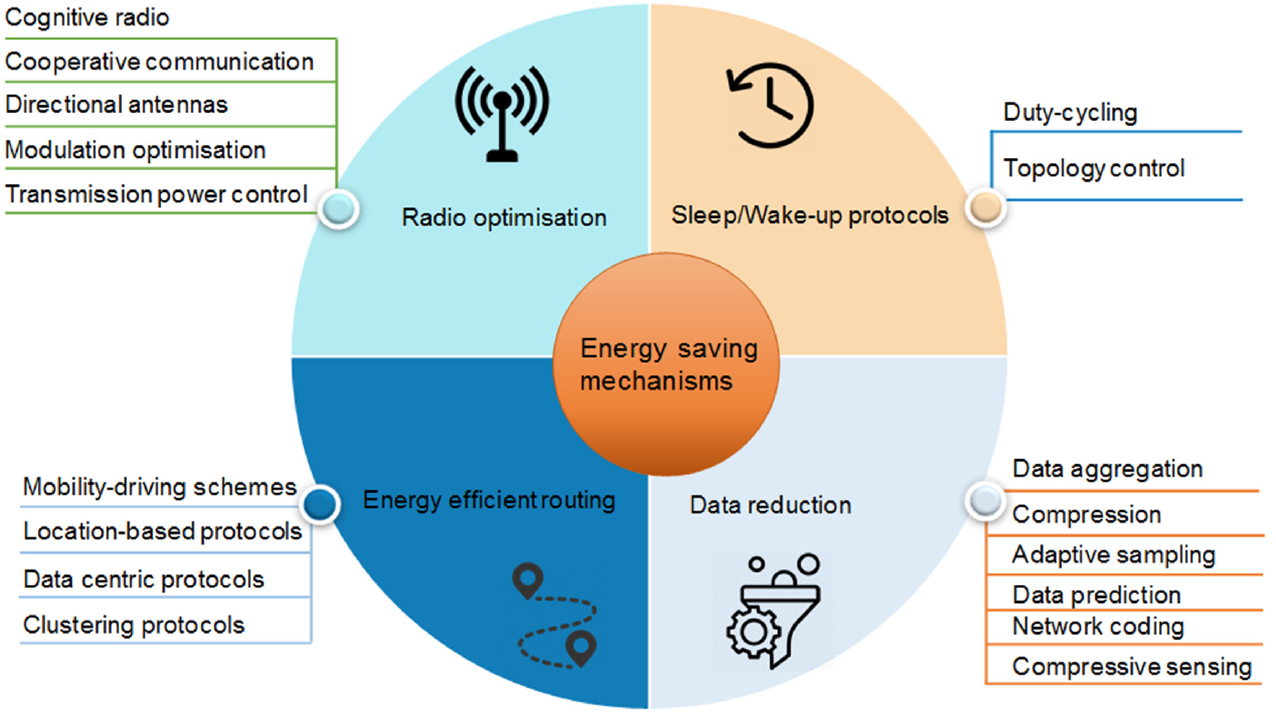
Figure 10. Energy saving mechanisms in wireless sensor networks.